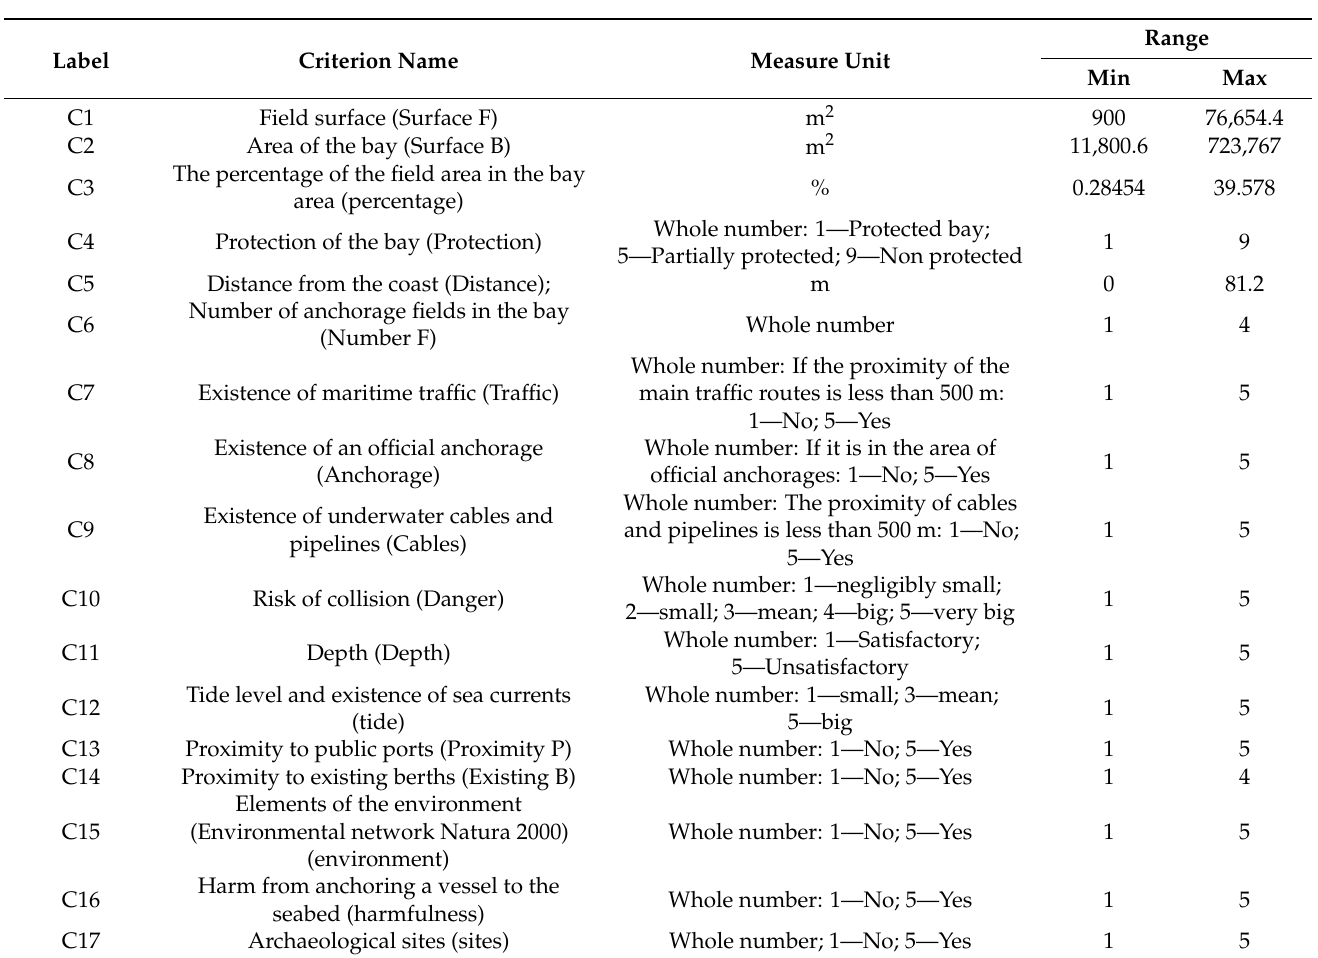
Table 5. Label, criterion name, measure unit, and range of input